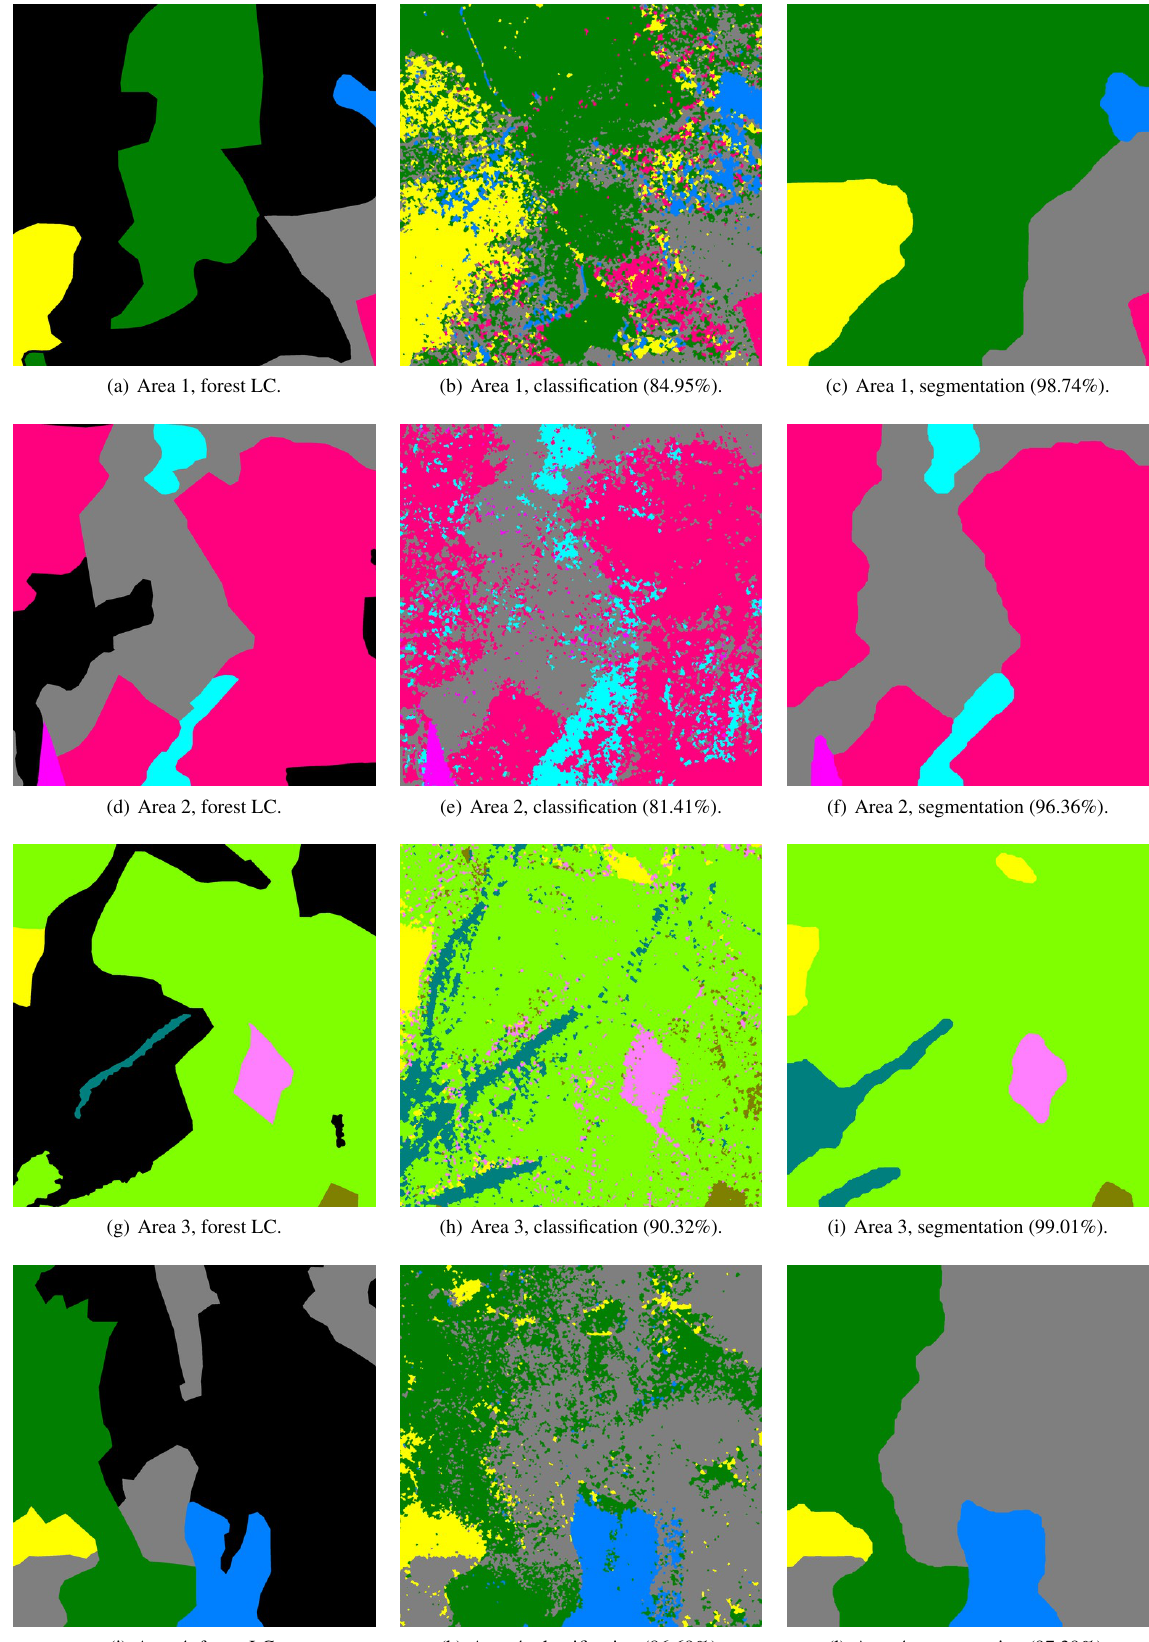
Figure 2. Results for all the 4 areas, the overall accuracy is specified in brackets. The smoothing is performed using the Exponential-features model with linear unary ( γ = 10 ). Color codes: beech , deciduous oaks , Scots pine , Douglas fir , fir or spruce , chestnut , robinia , larch , non-pectinated fir , black pine , herbaceous formation , no